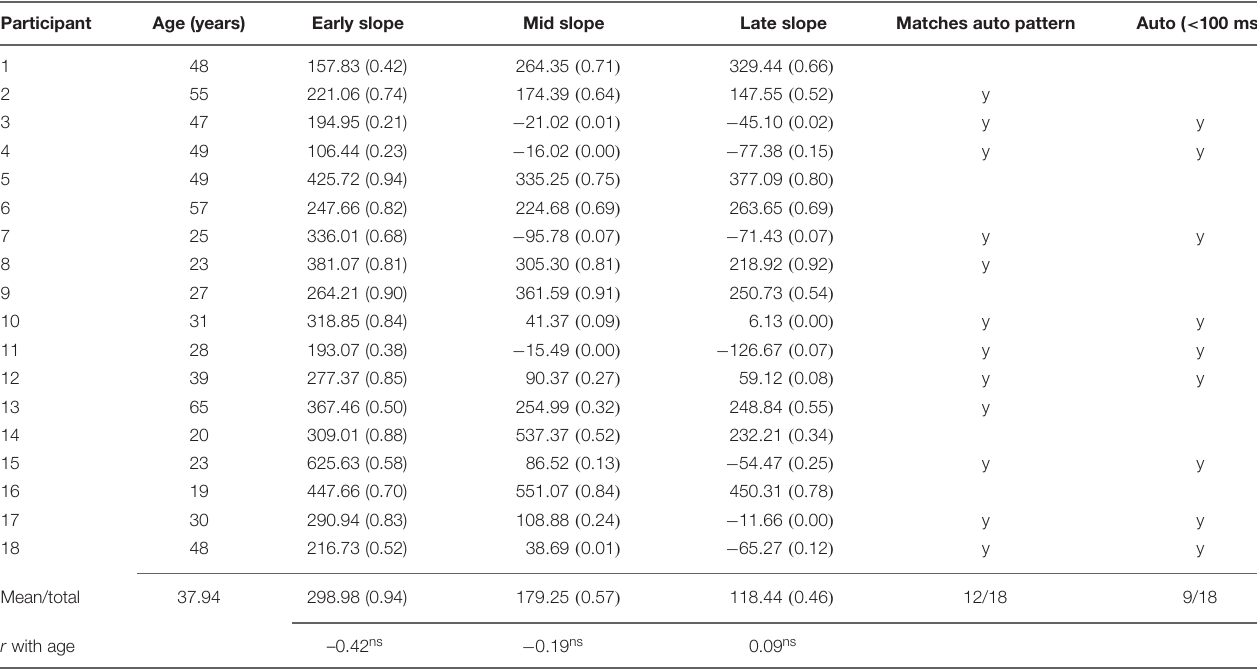
Values in parentheses are r 2 values for the regression lines. Matches auto pattern: y = yes, slopes descend from Early to Mid to Late. Auto ( < 100 ms): y = yes, slope = 100ms or less by the Late period. ns = p >